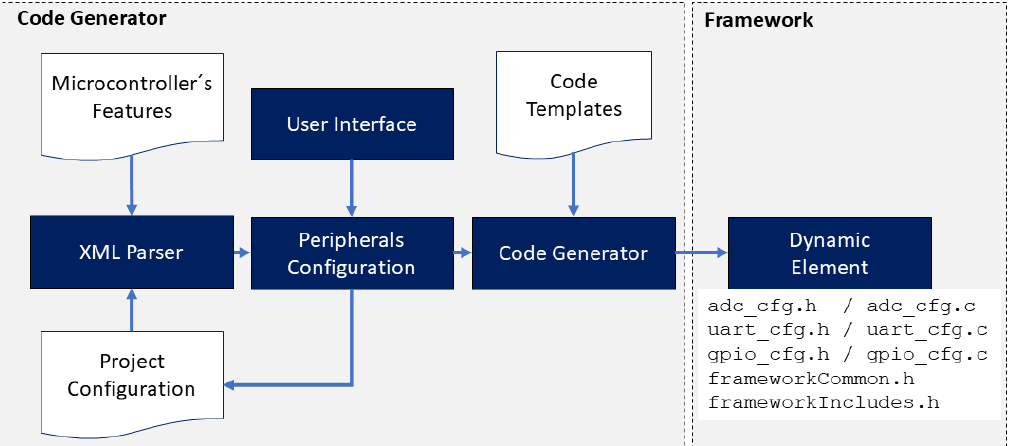
Figure 6. Implementation of the code generator that provides the dynamic elements to the framework.